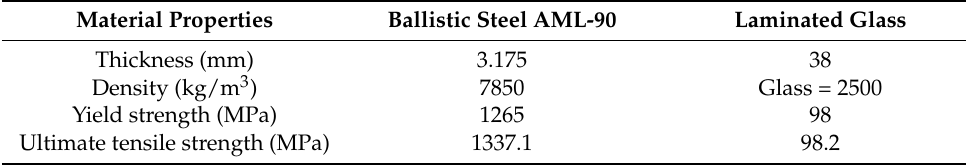
Table 1. Materials used for anti-assault type armoring.